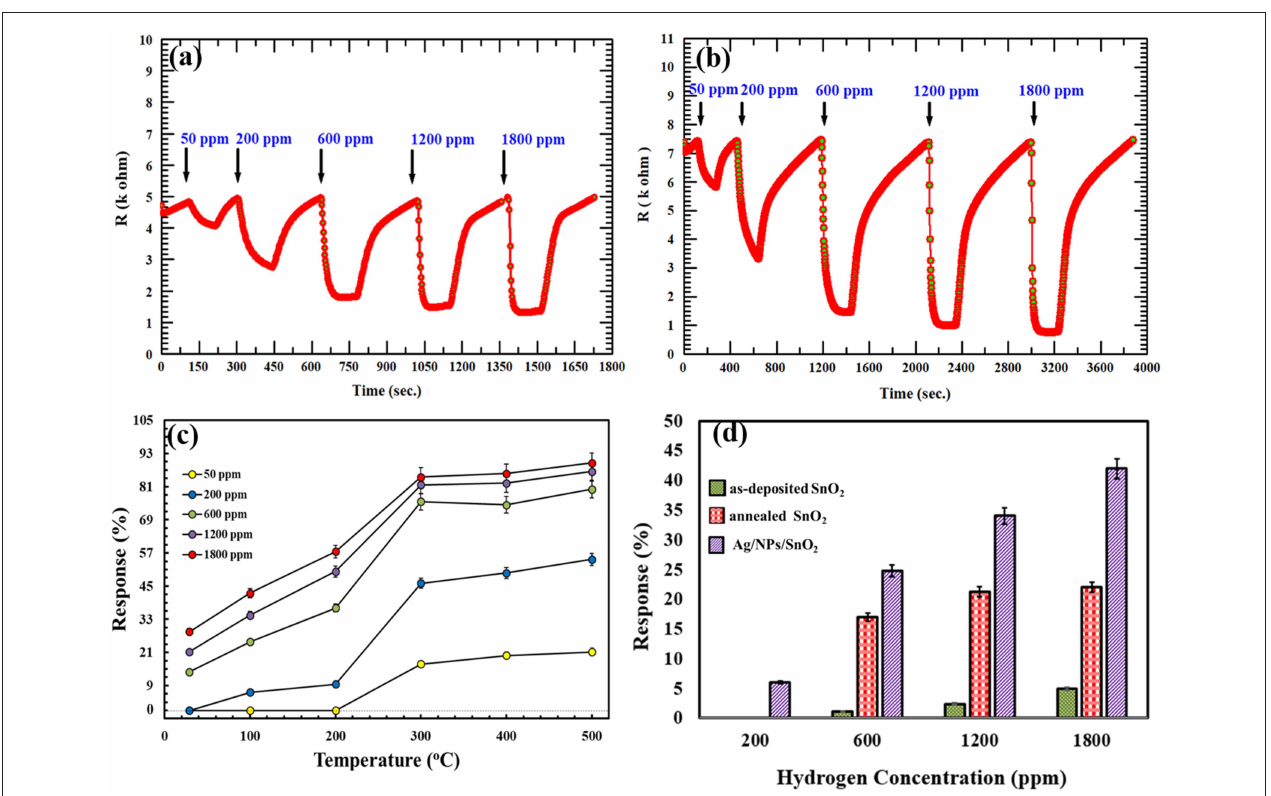
FIGURE 6 | (a,b) Dynamic responses of annealed SnO 2 and AgNPs/SnO 2 (respectively) gas sensor to different H 2 concentrations (50–1,800) ppm at 500 ◦ C. (c) Gas responses of